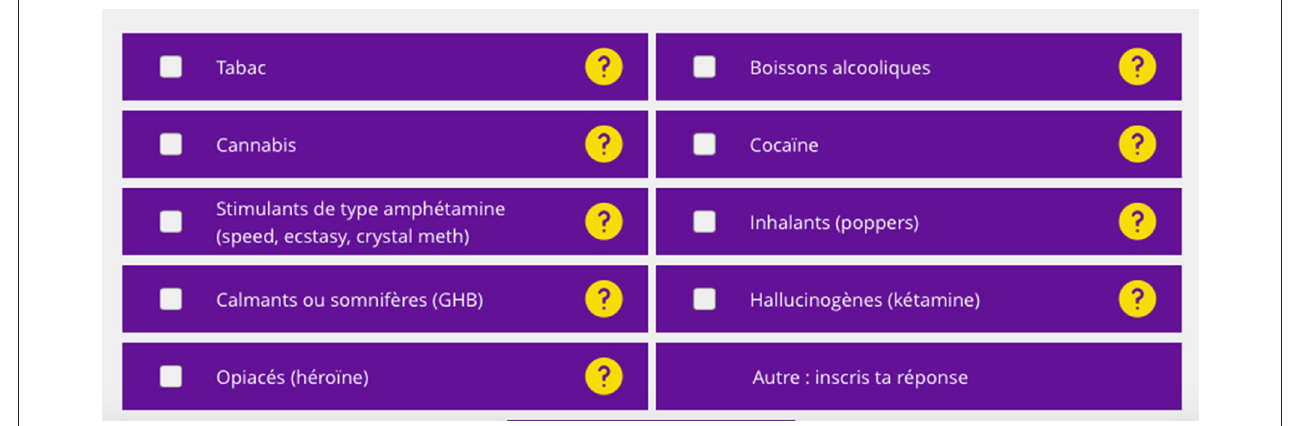
FIGURE 2 | Example of some ASSIT (53) questions.